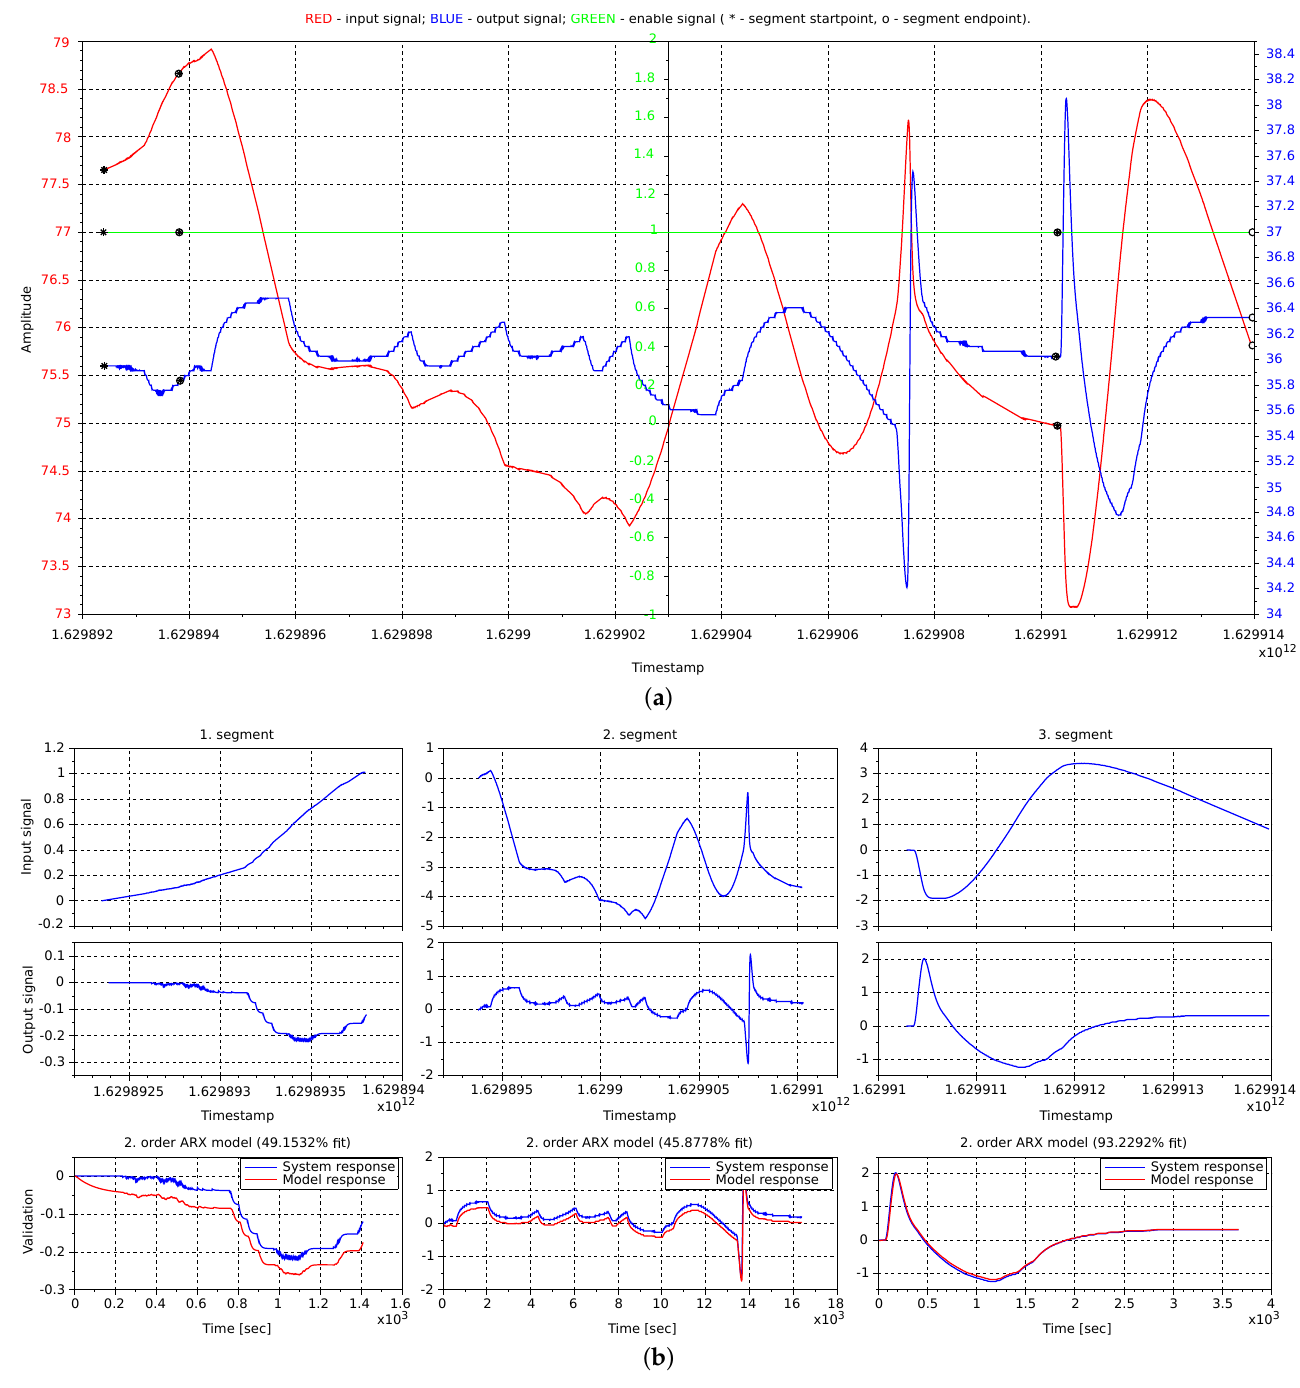
Figure 9. Graphical output from identification of the signal in the real building. ( a ) Input, output and enable/disable signals, and their segmentation. ( b ) Input and output data used for identification and model